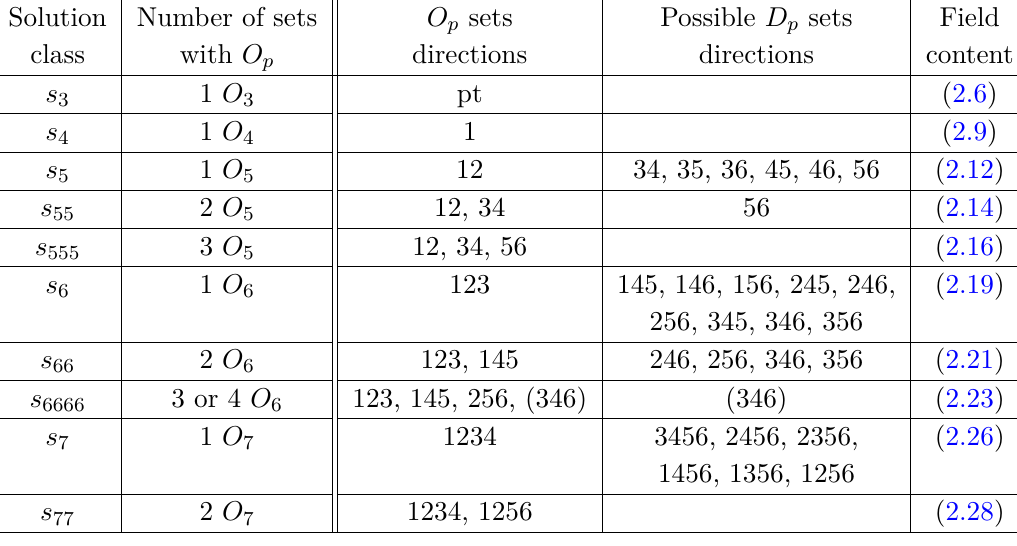
Table 2 . Source configurations allowed in our ansatz for a single dimensionality p , with at least one O . To each of those corresponds a list of variables or field content (structure constants, fluxes) p allowed by the orientifold projection. Together, these pieces of information define a solution class.